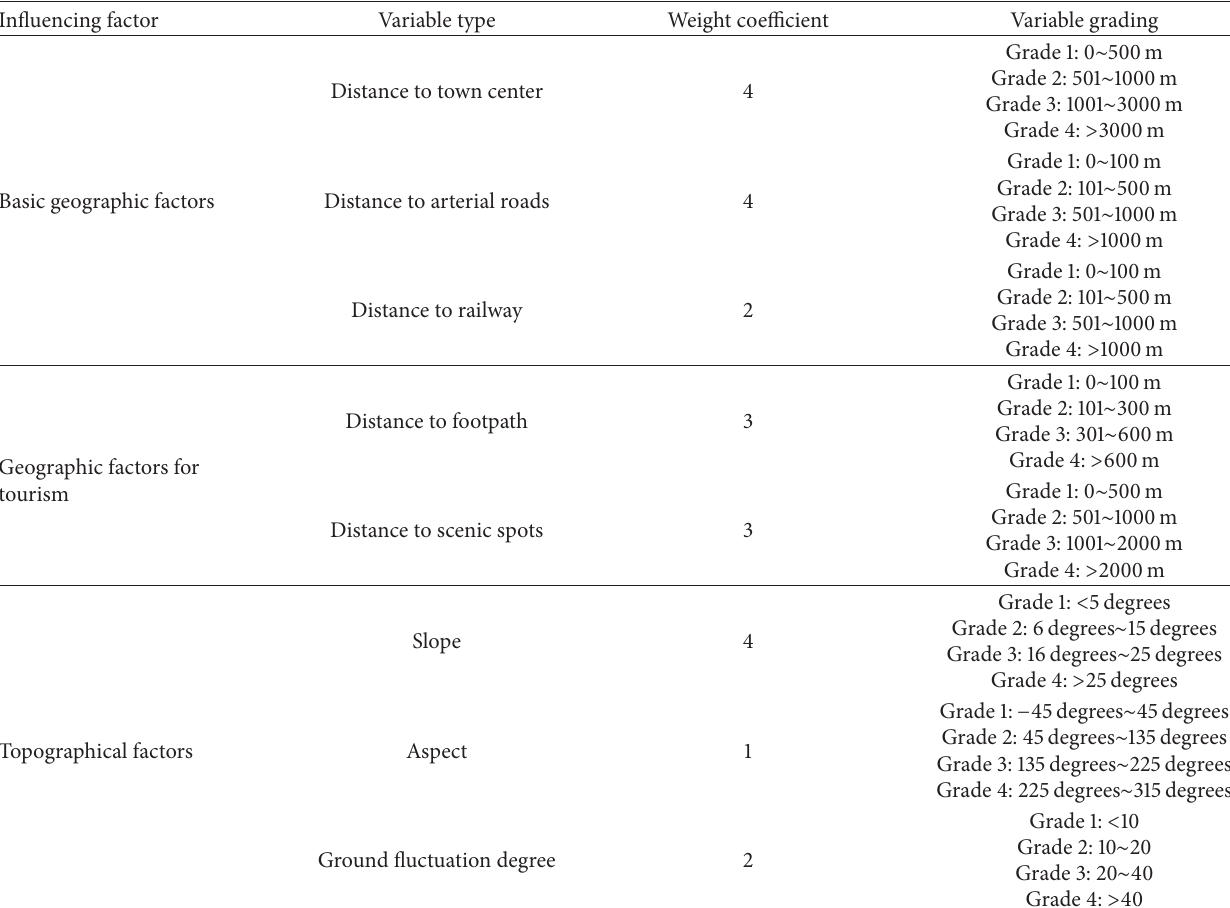
Figure 2: Frame diagram of spatio-temporal growth simulation of tourist town based on CA. Table 1: Driving factors and weights of spatio-temporal growth of tourist